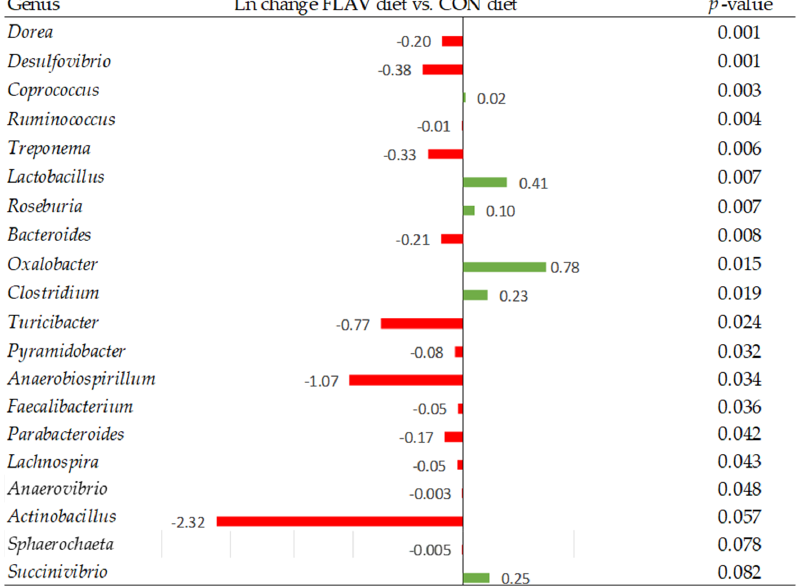
Figure 7. Differentially abundant taxa (Ln change) between diets supplemented with the flavonoid compound (FLAV) and the control diet (CON). Positive values (green color) and negative values (red color) indicate greater and lower abundance, respectively. Taxa are sorted by level of significance (from higher to lower). Only significant taxa are presented ( p- value < 0.10). Data are means of 6 replicate pens for the main effect of level (one pig per replicate pen was sampled).